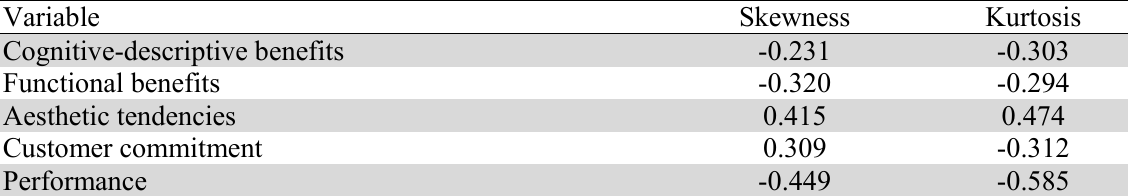
Skewness and kurtosis values to assess the normality of variables Variable